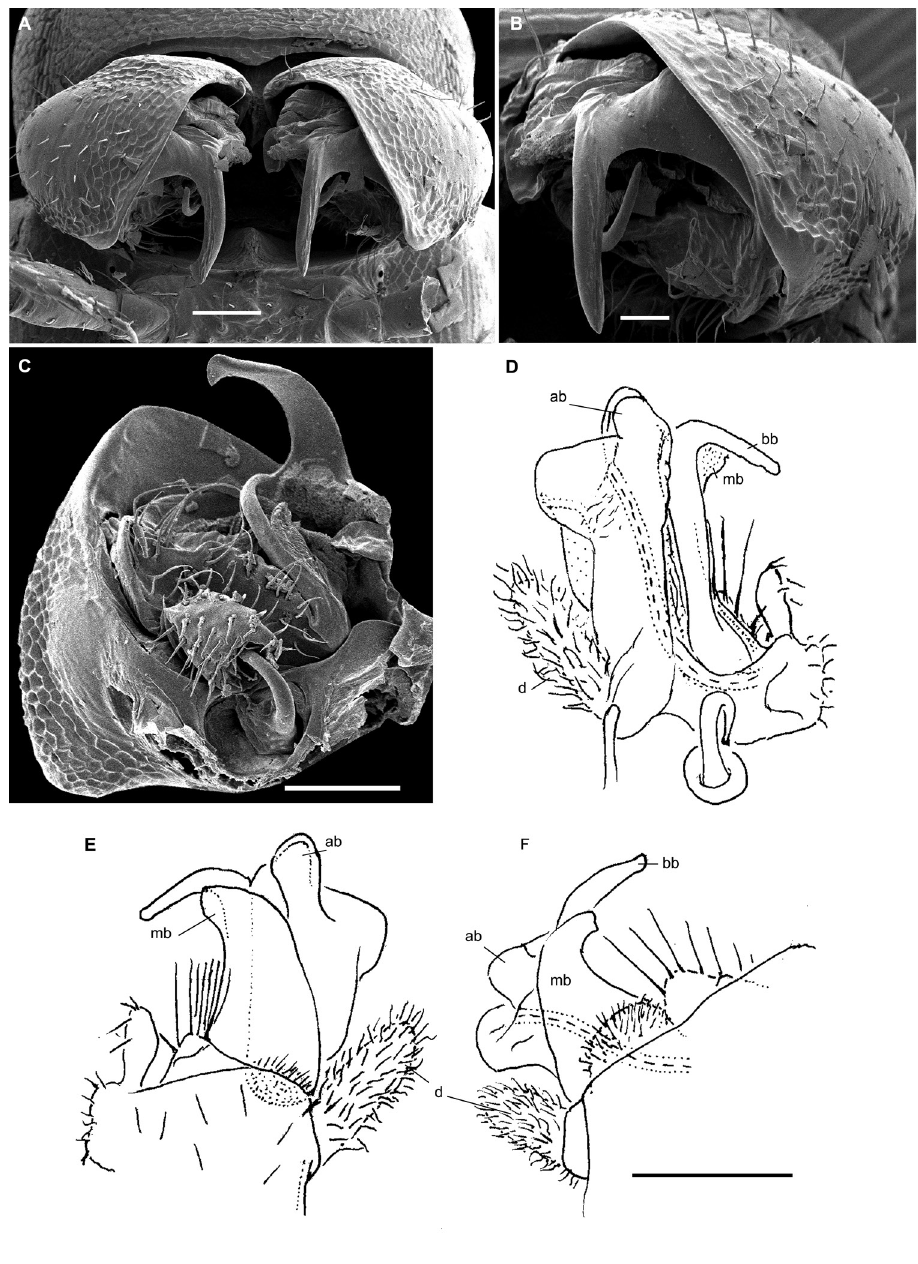
Figure 12. Hemisphaeroparia digitifer sp. n., ♂ paratypes A SEM micrographs of both gonopods in situ, ventral view B, C SEM micrographs of left gonopod, ventral view D, E right gonopod, mesal view F left go- nopod, mesal and lateral views, respectively. Scale bars: 0.05 mm ( A–C ), 0.1 mm ( D–F ). Abbreviations: ab apical branch of telopodite, bb basal branch of telopodite, d setose finger, mb medial branch of